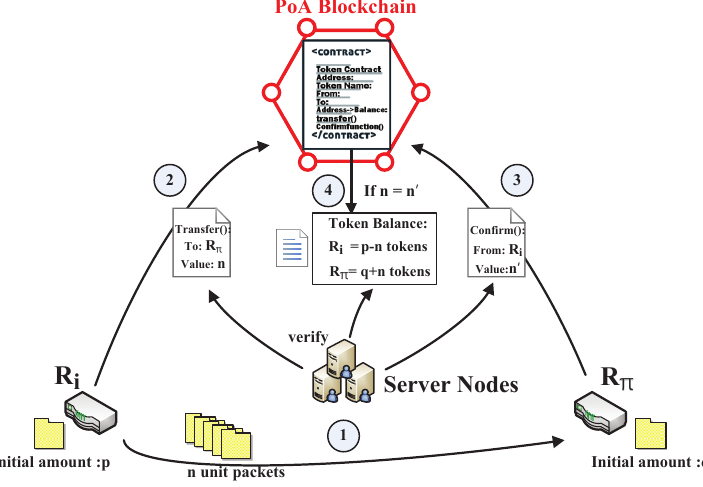
Figure 5. Implementation of the token